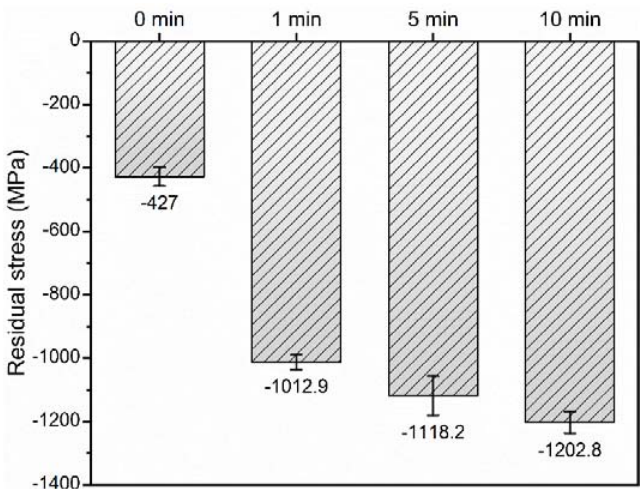
Figure 9. Residual stress after USP treatment.